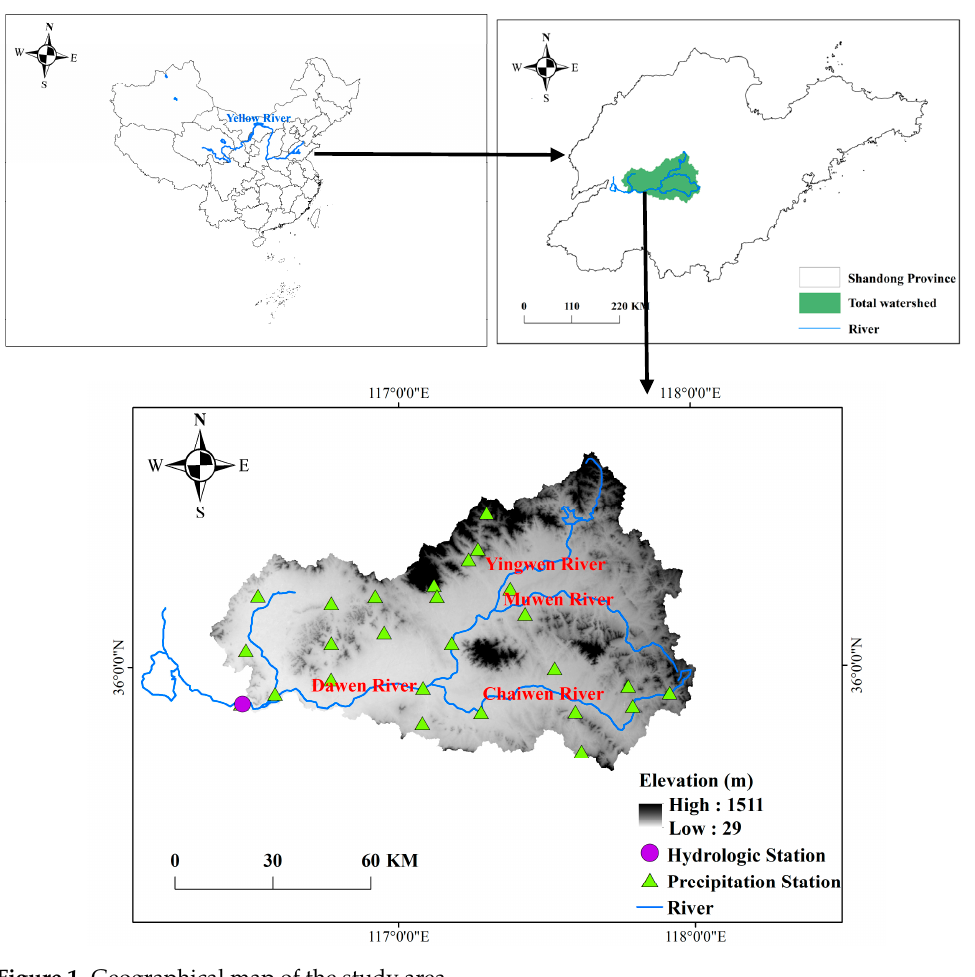
Figure 1. Geographical map of the study area.